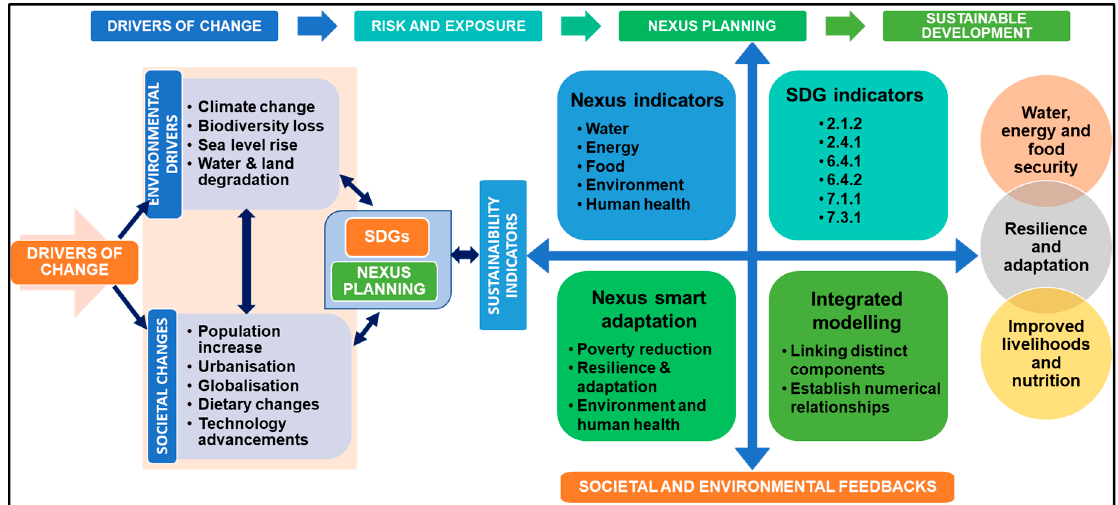
Figure 1. A conceptual framework linking nexus processes with Sustainable Development Goals (SDGs) .